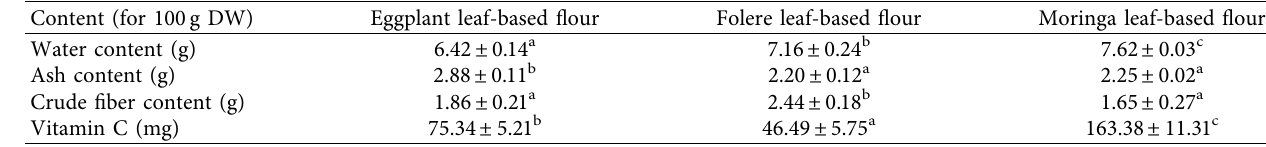
Table 5: Water, ash, fiber, and vitamin C contents of formulated flours.